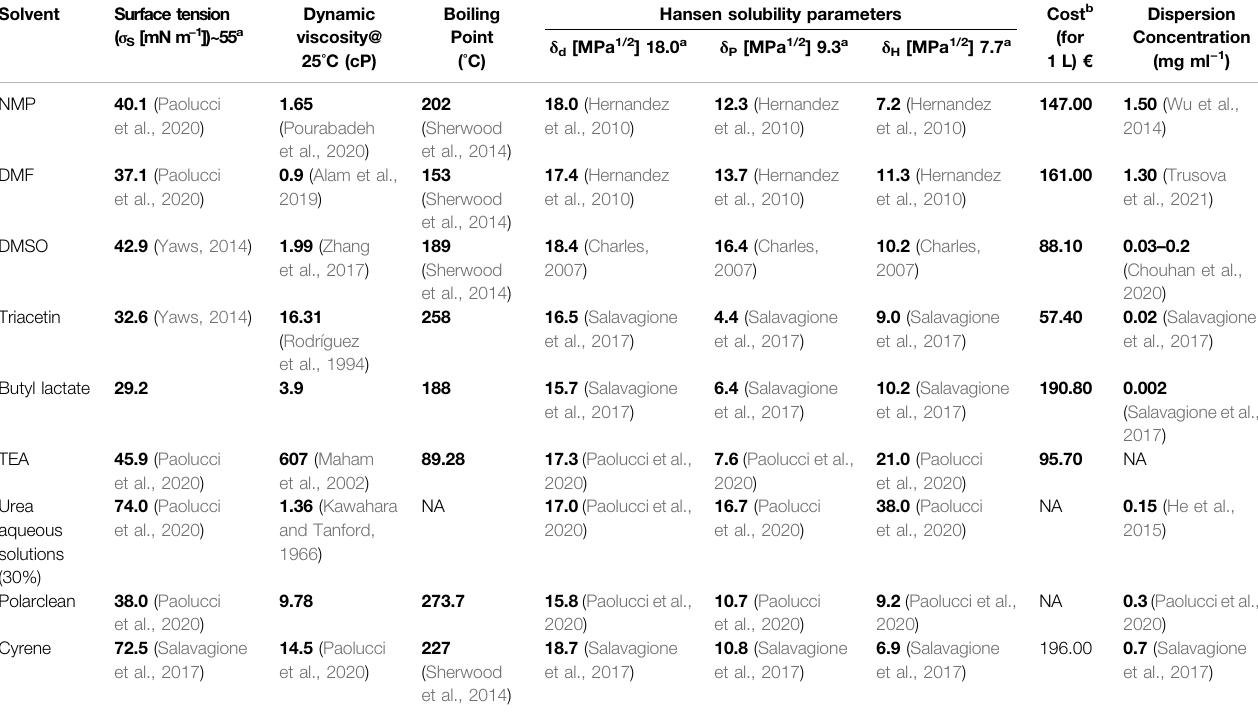
TABLE 1 | Summary of the features of conventional (NMP, DMF and DMSO) and green solvents used for LPE of graphite.